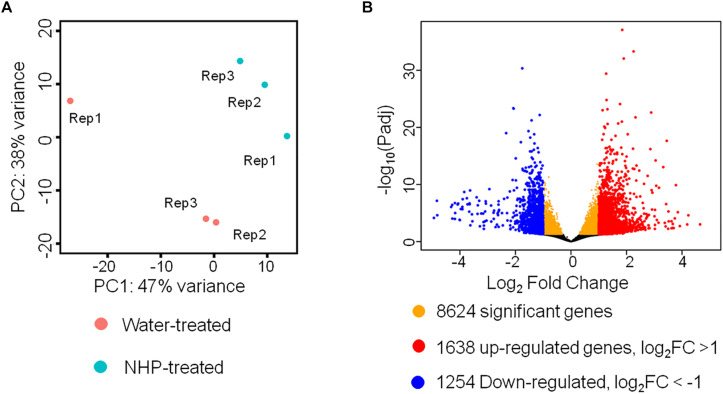
RNA sequencing results of wheat seedlings treated with water or N-hydroxypipecolic acid (NHP). (A) Principal component analysis (PCA) analysis of the transcriptomes of NHP-treated and water-treated wheat seedlings. (B) Volcano plot showing the distribution of differentially expressed genes. FC, fold change of NHP-treated sample with respect to mock-treated sample. False discovery rate (FDR) <0.05.